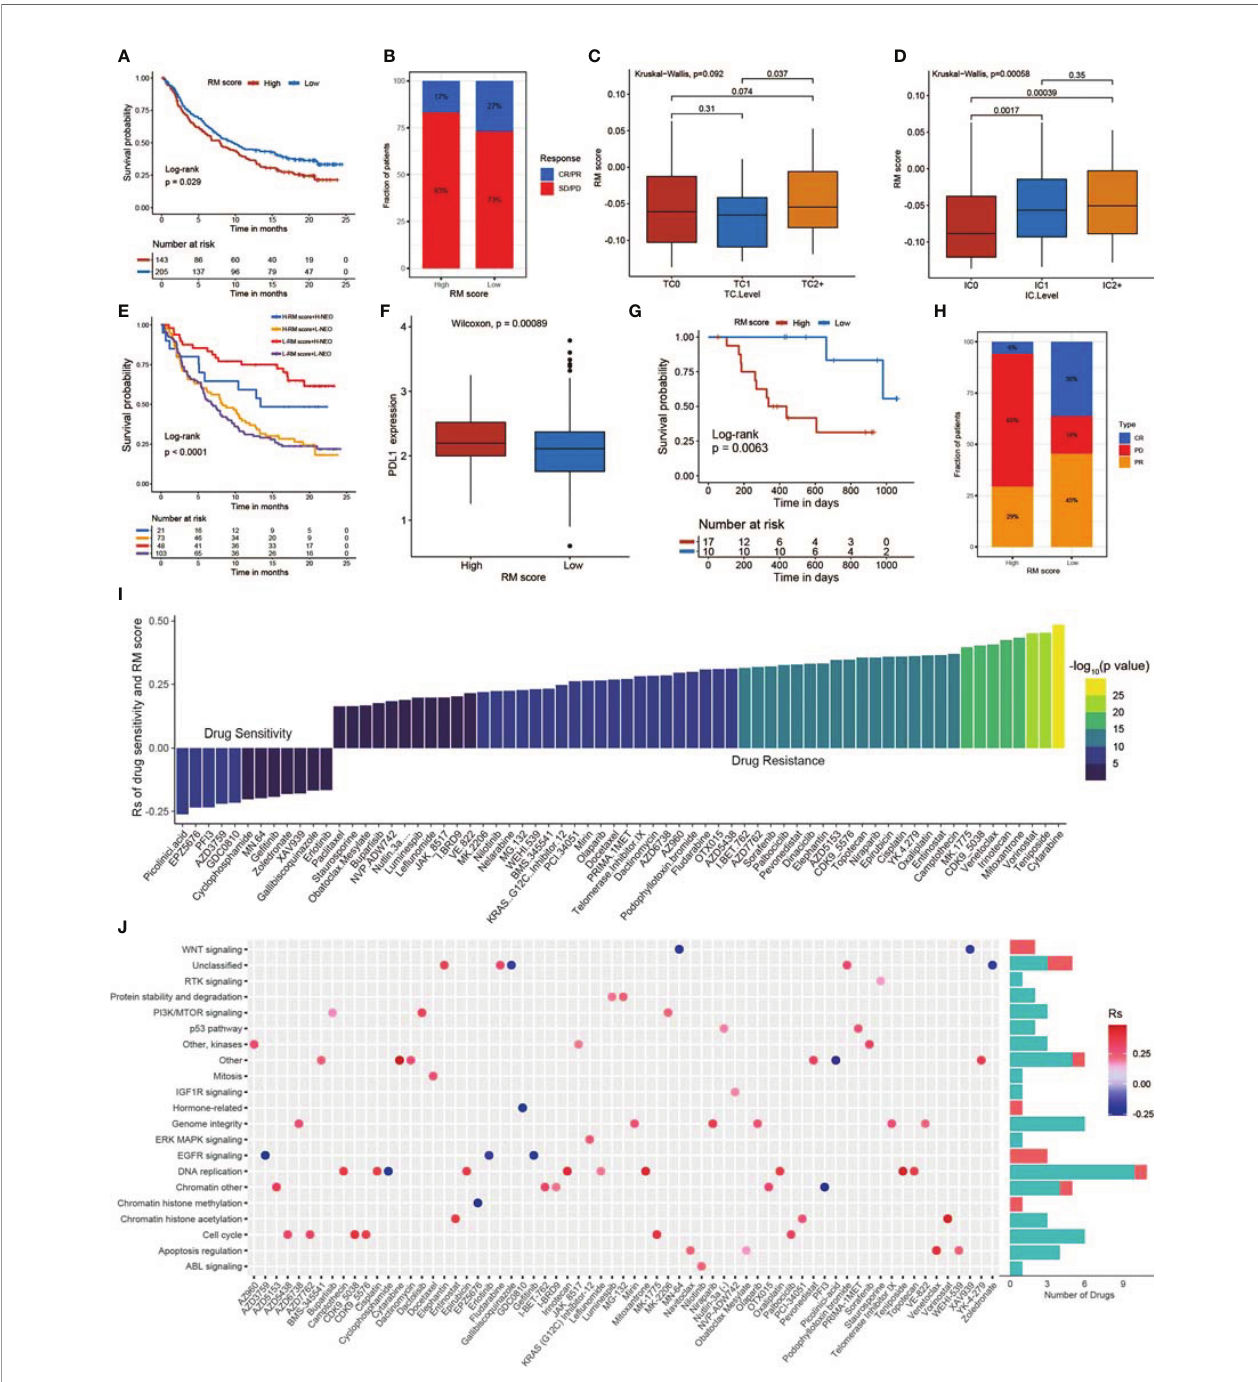
FIGURE 8 | The relationship between RM score and response to immunotherapy and drug sensitivity. (A) Survival analysis of the low and high RM score patient groups in an immune checkpoint blockade (ICB) therapy cohort. (B) The proportion of patients who responded to ICB therapy in the low or high RM score groups. (C) Differences in RM scores among the three tumor cell (TC) levels. (TC levels, level of IHC-assessed PD-L1 staining of tumor cells. TC0, <1%; TC1, ≥ 1% but <5%; TC2 + , ≥ 5% of tumor cells with staining for PD-L1, p = 0.092). (D) Differences in RM scores among the three immune cell (IC) levels. (IC levels, level of IHC-assessed PD-L1 staining of immune cells. IC0, <1%; IC1, ≥ 1% but <5%; IC2 + , ≥ 5% of immune cells staining for PD-L1, p = 0.00058). (E) Survival analyses of patients receiving ICB therapy strati fi ed by RM score and TMB. (F) Differences in PD-L1 expression between the high and low RM score patients. (G) Survival analyses of the high and low RM score patient groups in another ICB therapy cohort (GSE78220). (H) Proportion of patients who responded to ICB therapy in the low or high RM score groups. (I) The relationship between RM score and drug AUC value. (J) Signal paths targeted by drugs whose AUC values are positive (red) or negative (blue) with RM